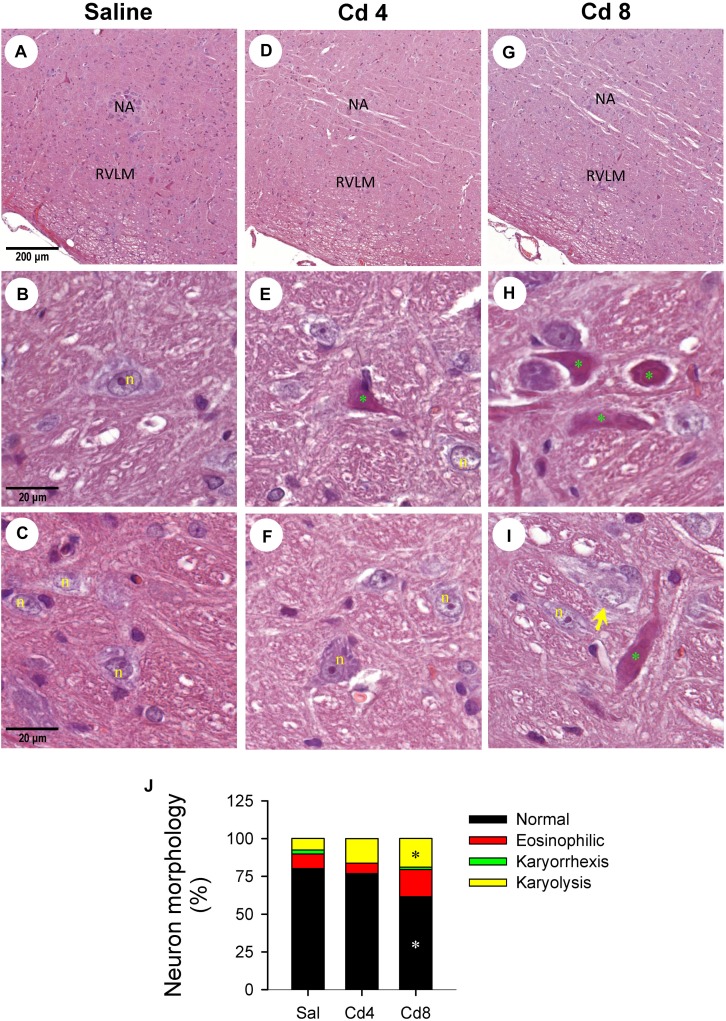
Representative photomicrographs of RVLM stained by hematoxylin and eosin showing nuclear karyolysis and eosinophilic neurons in rats that received saline (A–C), 10 min after cadmium (Cd; 4 mg/kg, iv) (D–F), or died from Cd (8 mg/kg, iv) (G–I). (J) Stacked bar plots showing the average distribution of neurons in RVLM (in percentage) based on morphology from hematoxylin and eosin staining. These results are typical of 3–4 animals from each experimental group. *P < 0.05 vs. saline (sal) group. In (A–I), NA, nucleus ambiguus; n, nucleus; green symbol (*), eosinophilic neuron; yellow arrow, neuron exhibiting karyolysis.